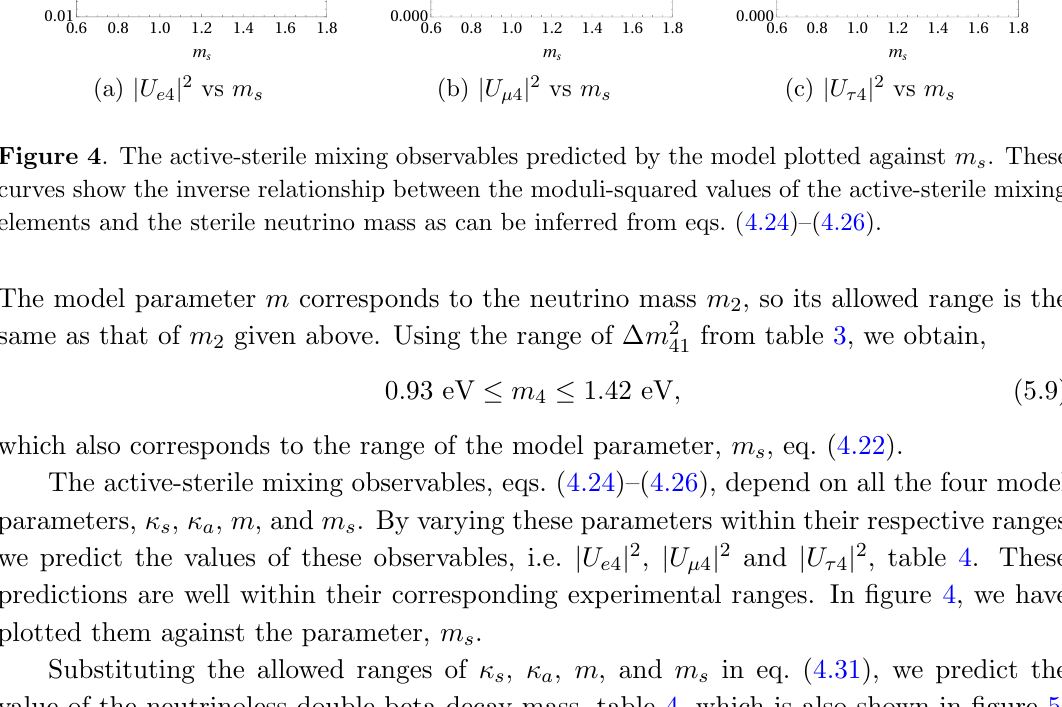
0.6 0.8 1.0 1.2 1.4 1.6